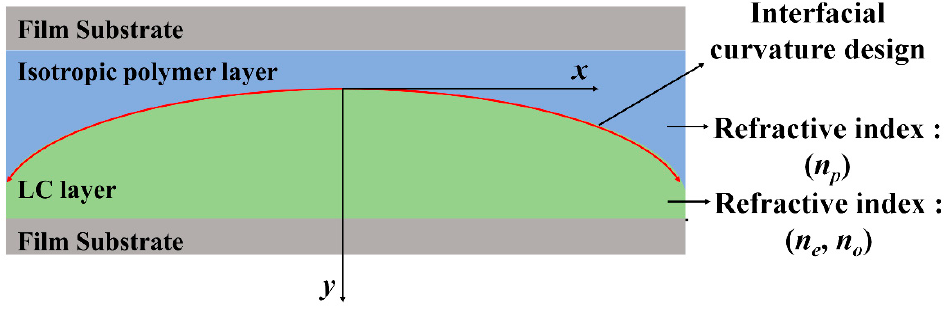
Figure 2. Schematic of the interfacial curvature design between the plano-concave isotropic polymer layer and the plano-convex birefringent LC layer in an LC-based GRIN lens layer and the plano-convex birefringent LC layer in an LC-based GRIN lens array.